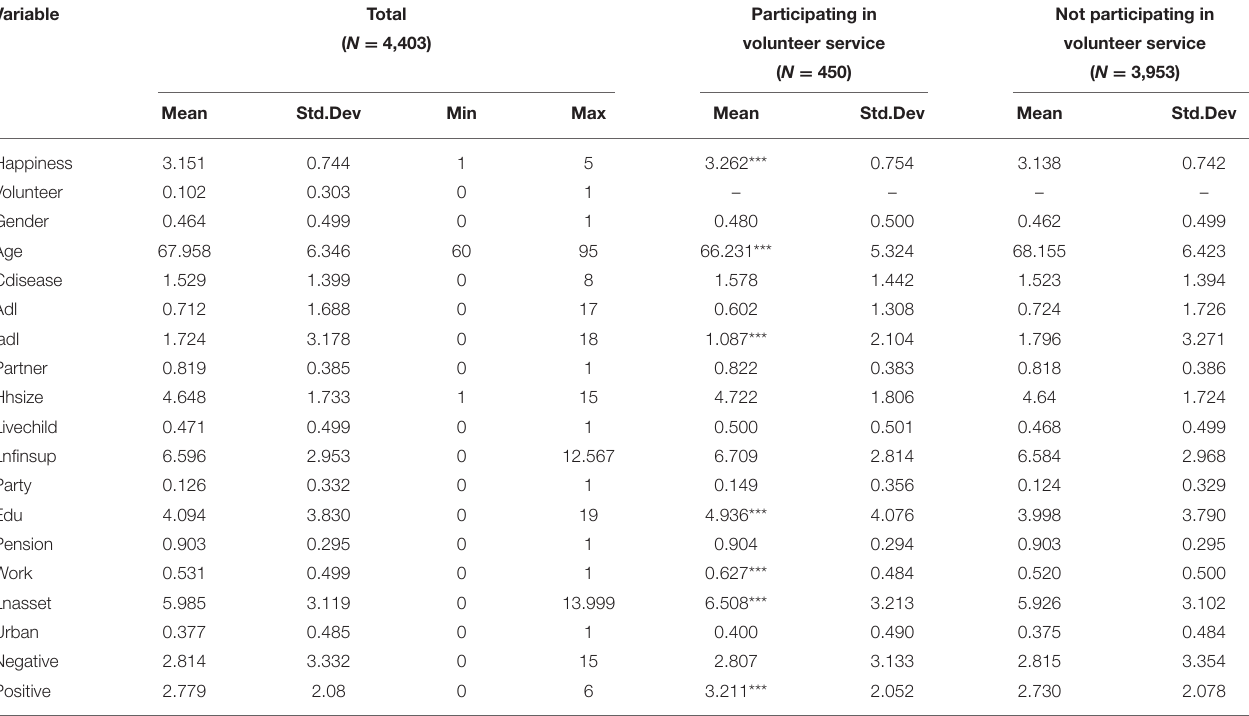
TABLE 2 | Descriptive statistics of